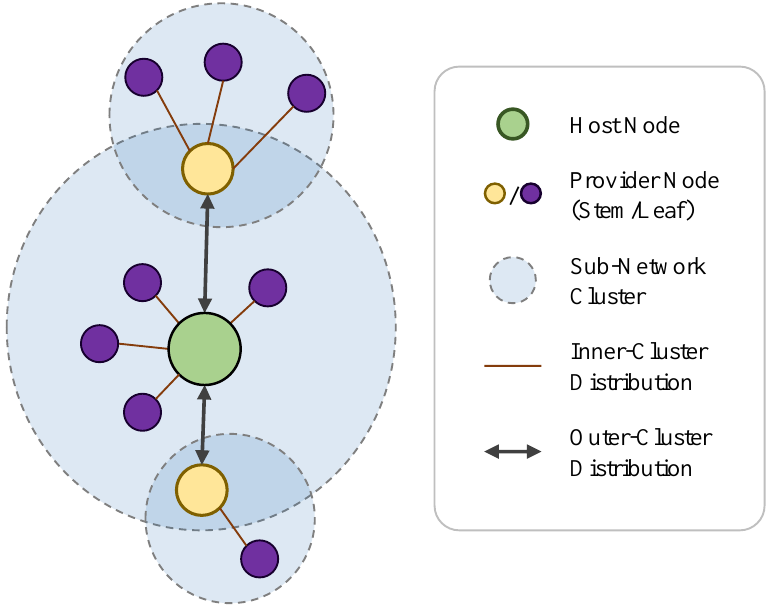
Figure 5. Resource provider network structure for task